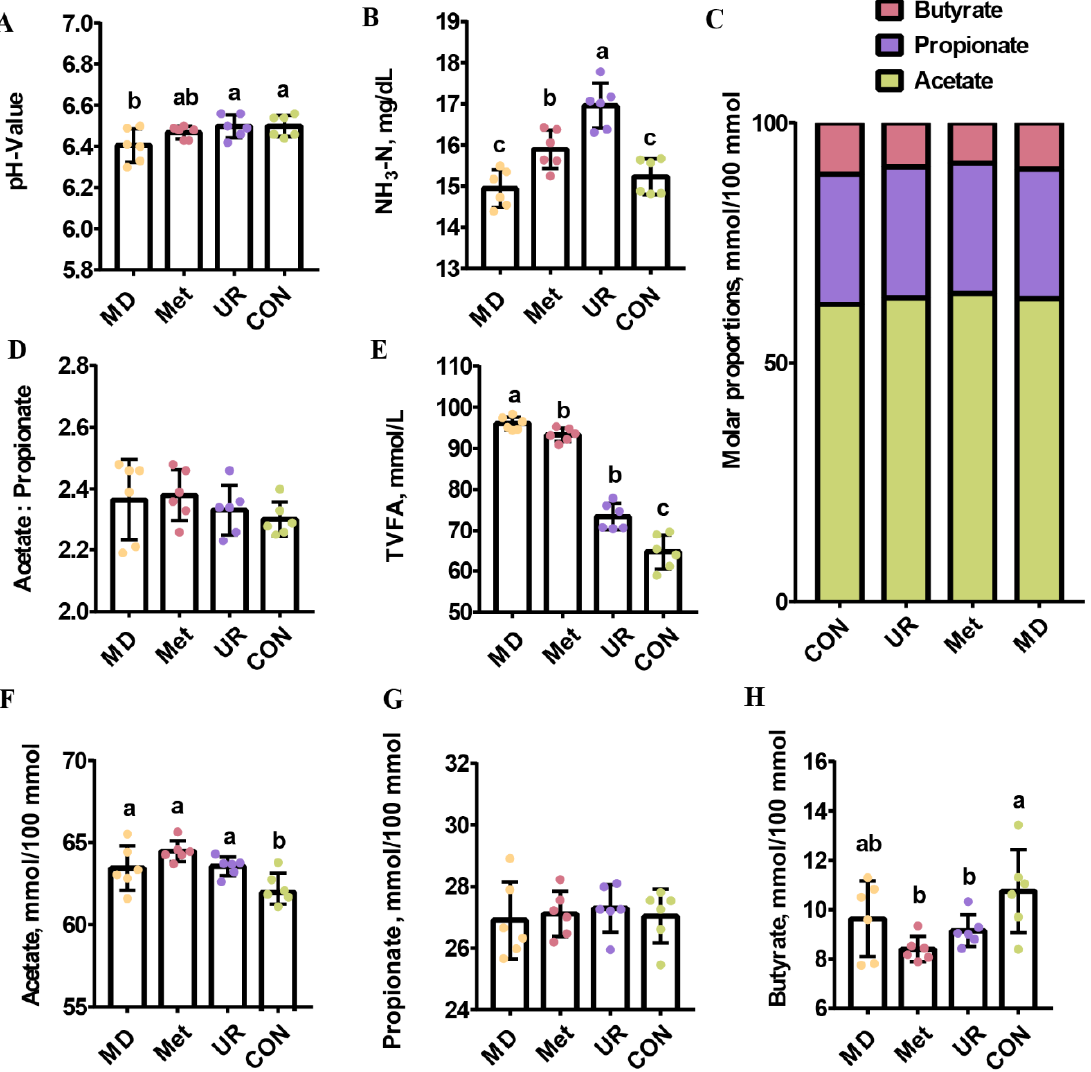
Figure 3. Effects of urea, methionine, and methionine dipeptide on in vitro pH value ( A ), ammonia concentration ( B ), and volatile fatty acid composition ( C – H ) of total mixed ration during 48 h incubation. CON = no additive, UR = urea addition, Met = methionine addition, and MD = methionine dipeptide addition. Individual volatile fatty acids are represented as molar proportions (mmol/100 mmol. F – H ). Means with different letters (a–c) are significantly different ( p < 0.05). Vertical bars denote standard deviation (SD); n = 6 per treatment per time.